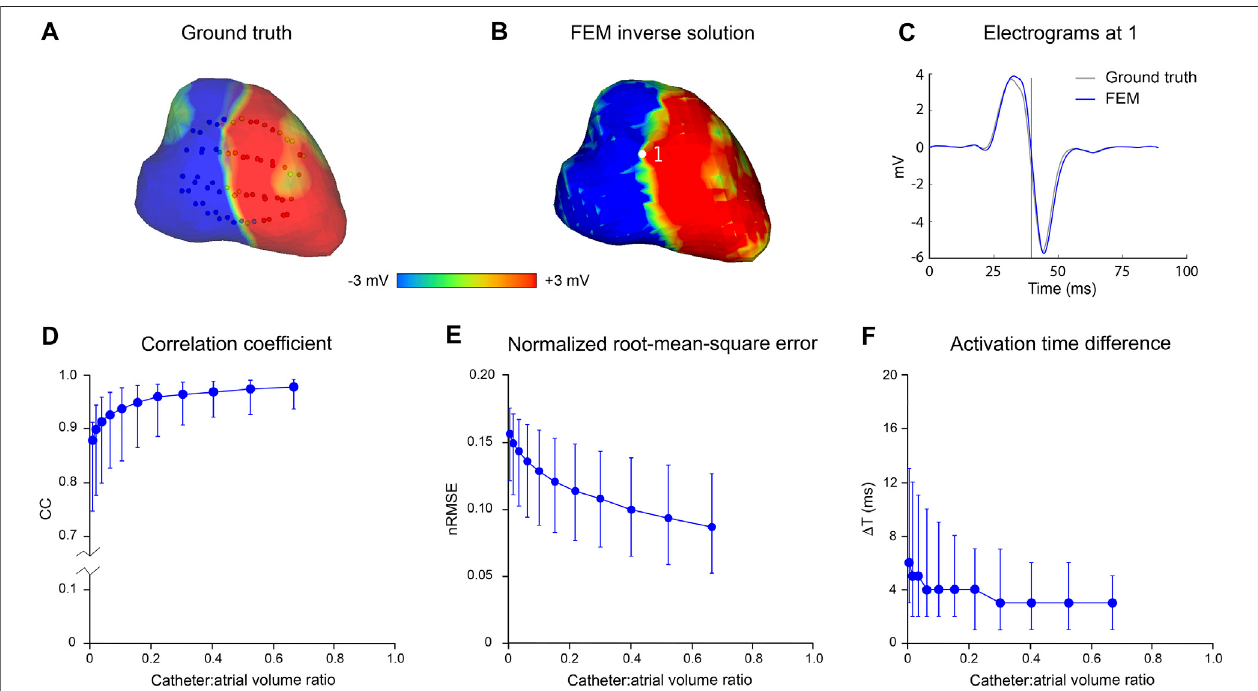
FIGURE 3 | Effect of catheter size on accuracy of inverse potential mapping. Comparison of ground truth potential maps on endocardial surface of LA in SR with inversemapsreconstructedusingFEM.Inversepotentialmapswerereconstructedfromelectrograms “ sampled ” usinga64-electrodebasketcatheter,withcentroidsof catheterandLAchamberaligned.Theupperpanelpresentstypicalresultsforacatheterwhichboundsavolumefractionof0.67relativetoLAvolume.Theseinclude (A) ground-truth surface potential distribution 43.9 msec after onset of activation with basket catheter superimposed, and (B) corresponding potential maps reconstructed using FEM. Finally, in (C) a ground-truth electrogram (black) at point 1 is compared with corresponding electrograms reconstructed using FEM (blue). In the lower panel, (D) correlation coef fi cient (CC) (E) normalized root-mean-squared error (nRMSE), and (F) activation time difference ( Δ T) are presented as functions of relative catheter volume for FEM. Median values and interquartile range are given. Abbreviations: FEM, fi nite element method; SR sinus rhythm.